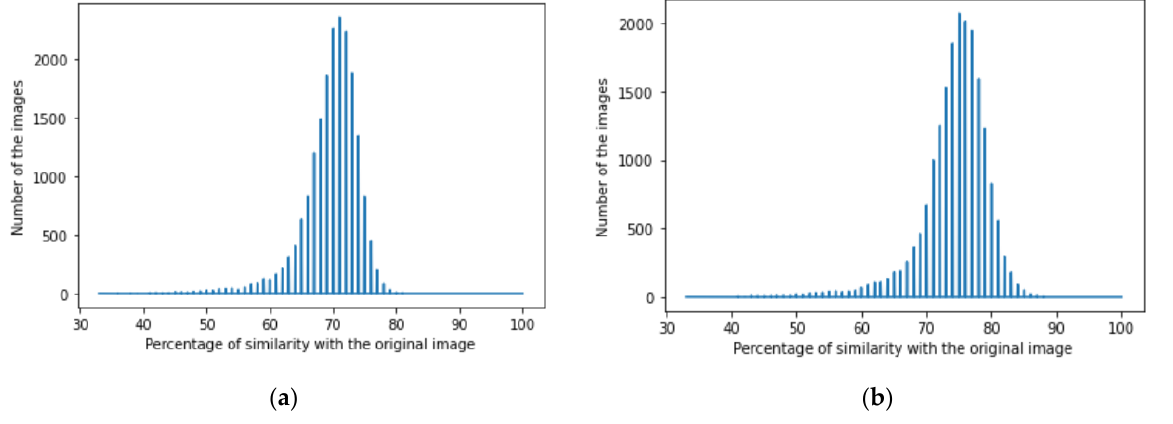
Figure 7. The histogram of similarity between the predicted denoised image and the original image in the case of Poisson noise: ( a ) one autoencoder with convolutional neural networks; ( b ) dual autoencoder with convolutional neural networks.